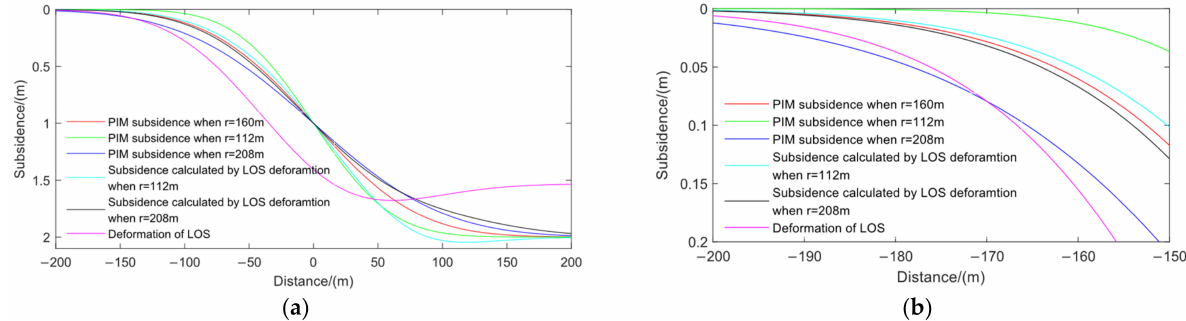
Figure 23. Comparison of deformations under different r. ( a ) The open-off cut area; ( b ) the edge area. Figure 23 shows the subsidence calculated by the PIM and the subsidence curves calculated by InSAR combined with the depression angle model when r is 112 m and 208